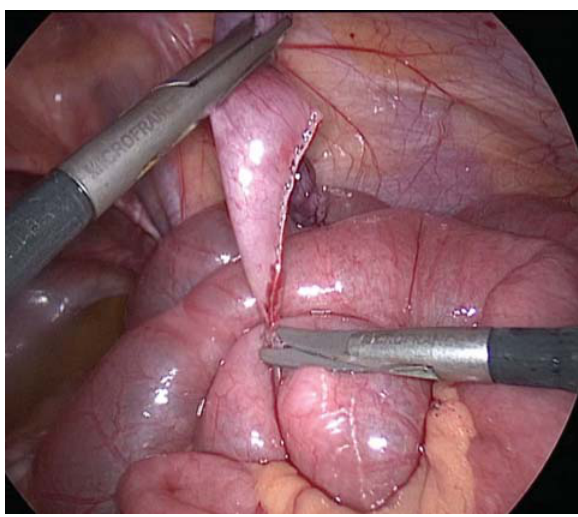
Fig. 3 Laparoscopic stapler diverticulectomy. The fi rst base.